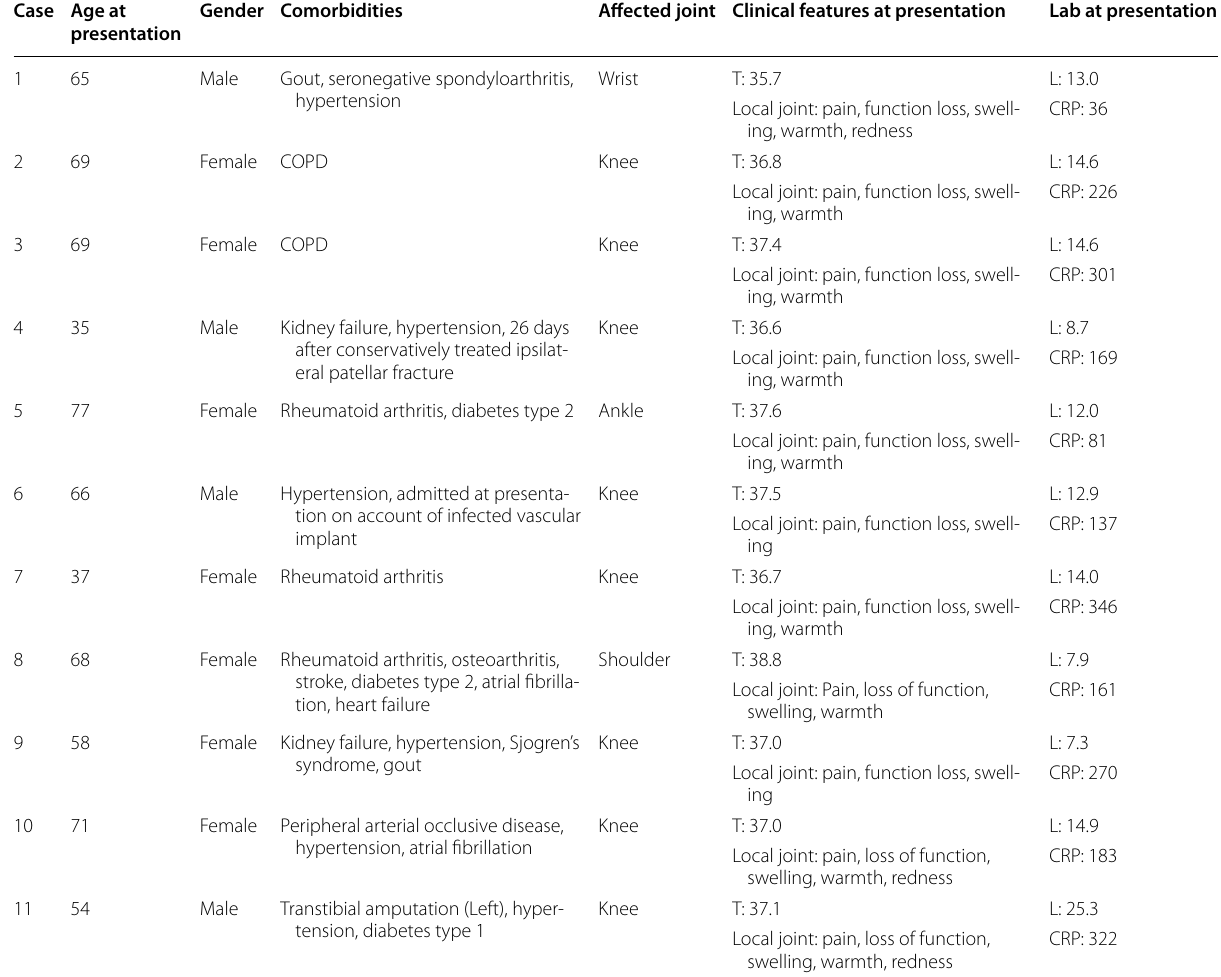
Table 1 Patient characteristics